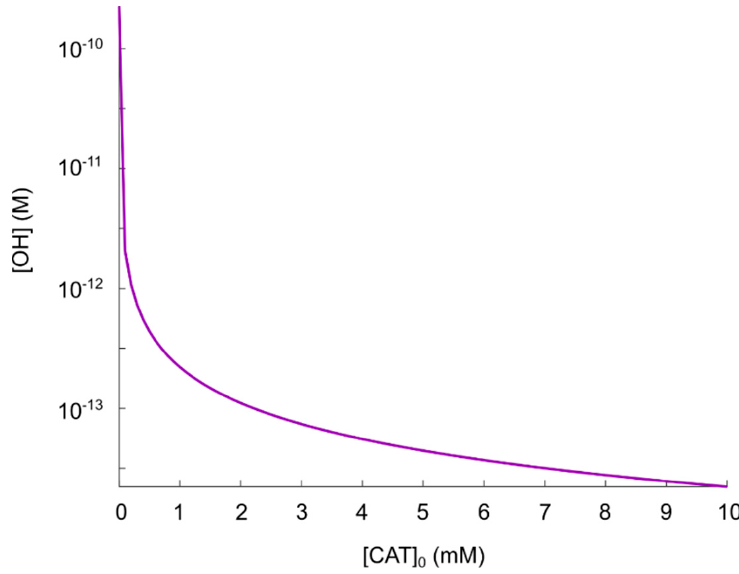
Figure 4. Maximal concentration of hydroxyl radicals as a function of catalase concentration in the regime 0 ≤ [𝐶𝐴𝑇] (cid:2868) ≤ 10 (cid:2879)(cid:2870) M .